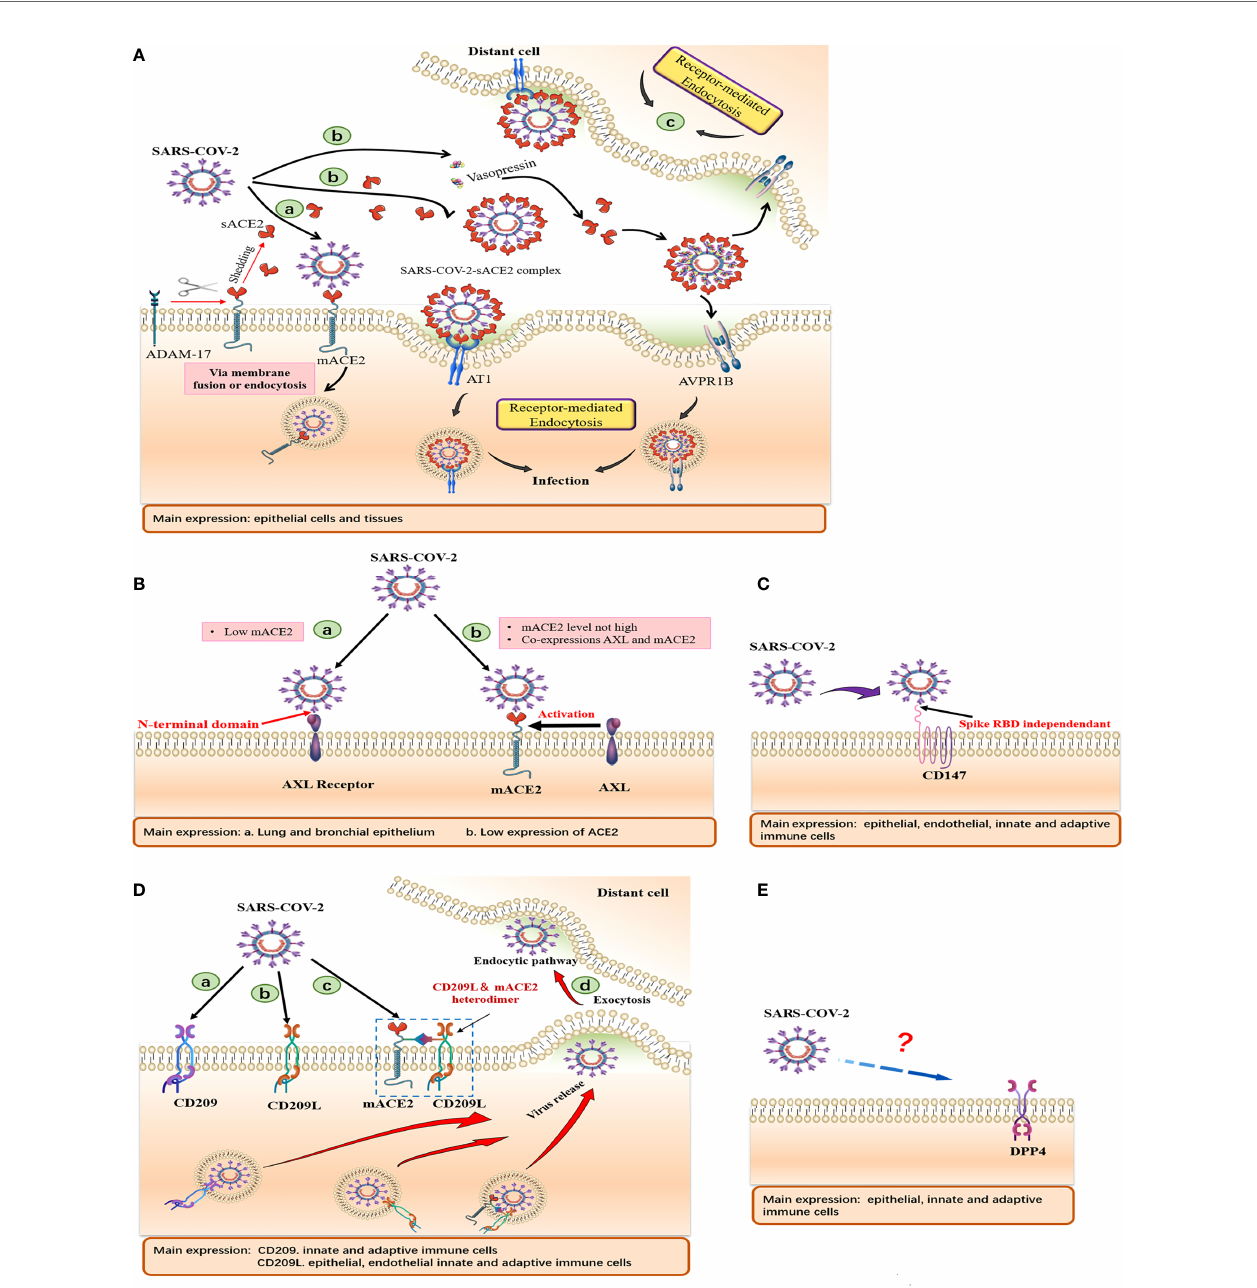
FIGURE 3 | Schematic of cell surface receptors mediated entry of SARS-CoV-2. Summary of tissue and cellular expressions, and models of (A) ACE2, (B) AXL, (C) CD147, (D) CD209, CD209L and (E) CD26. (A) (a) Virus gains entry into host cells via mACE2. (b) SARS-CoV-2 binds sACE2 to form an sACE2-virus complex, which subsequently enters host cells through AT1 and AVPR1B receptors mediated endocytosis. (B) (a) AXL acts as a membrane receptor and its NTD binds SARS-CoV-2 to mediate viral entry. (b) AXL, as a host factor facilitating viral entry, cooperates with ACE2 to promote viral entry at low ACE2 expression levels. (D) (a, b). CD209 and CD 209L acts as membrane receptors that mediate viral entry. (c) CD209L can form heterodimerization complexes with ACE2 to mediate viral entry. (d) Cells expressing DC-SIGN and L-SIGN can transfer SARS-CoV-2 to susceptible target cells, release virus through exocytosis and mediate distant cell